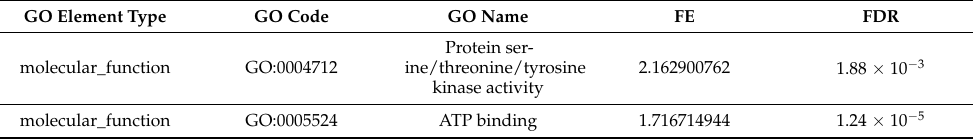
Table 8. Enrichment Analysis for Cluster